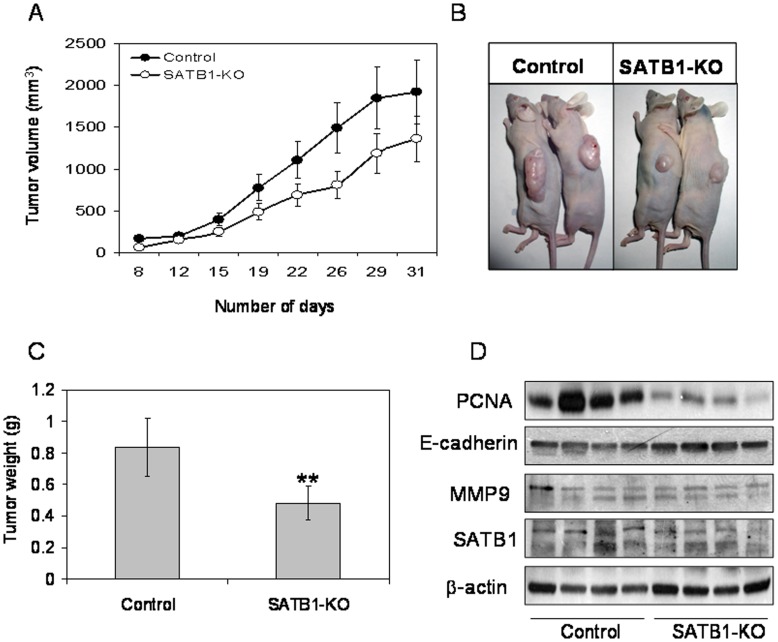
Effect of SATB1 knock down in tumor growth in athymic nude xenograft.(A) SATB1 knockout in PC-3M cells resulted in decrease in tumor volume. (B) Photograph of tumor xenograft in PC-3M and SATB1-KO tumors. (C) Tumors were excised, weighed, and measured at the termination of the study. Tumor weight was significantly reduced in SATB1-KO tumors in athymic nude mice. Approximately 1×106 cells were injected in the flanks of each mouse to initiate ectopic prostate tumor as described in ‘materials and methods’. Tumor size were measured twice weekly in two dimensions throughout the study. Tumor volume (mm3) and wet weight of tumors are represented as the mean of 8–10 tumors in control PC-3M and SATB1-KO PC-3M tumors. **P<0.003; Bars; Mean ± SE. (D) Western Blots for PCNA, E-cadherin, MMP9, and SATB1 in tumor lysates from PC-3M and SATB1-KO tumors. The blots were stripped and reprobed with anti-<beta>-actin antibody to ensure equal protein loading by a representative blot. Details are described in ‘materials and methods’ section.